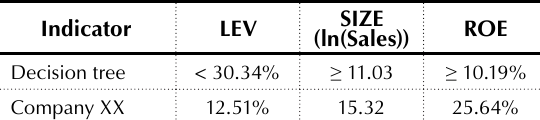
Table 7. Parameters of company X